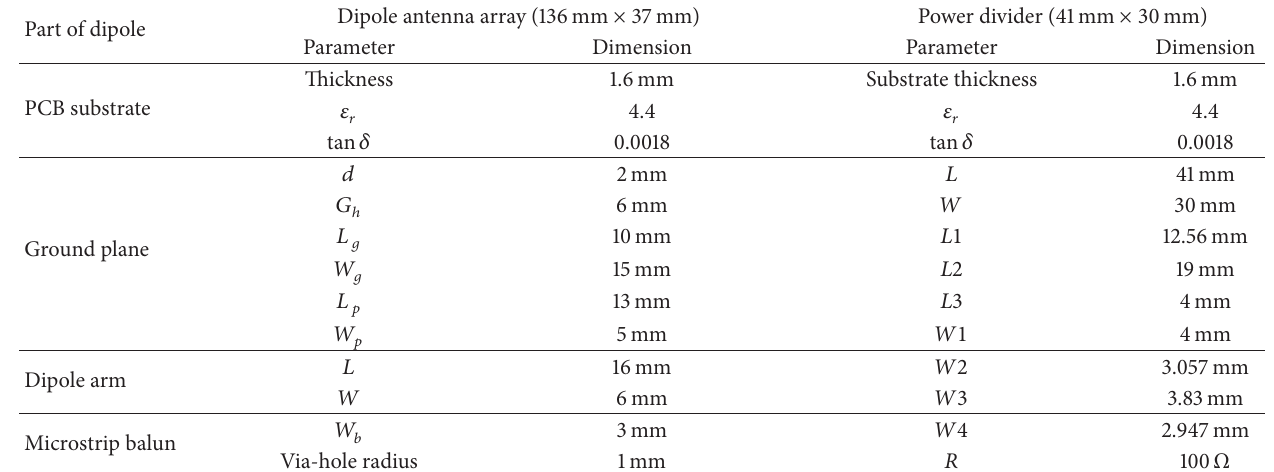
Table 1: Structural parameters of dipole antenna array and power divider.